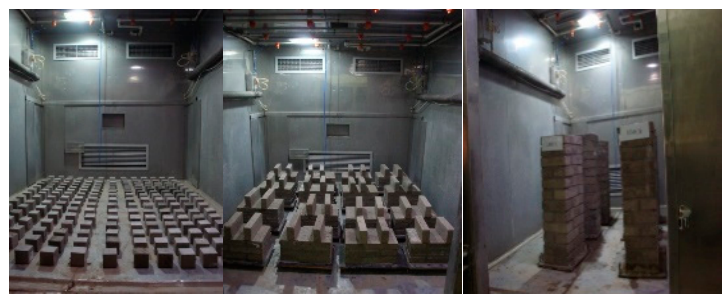
Figure 2. Specimens in laboratory exposure chambers.